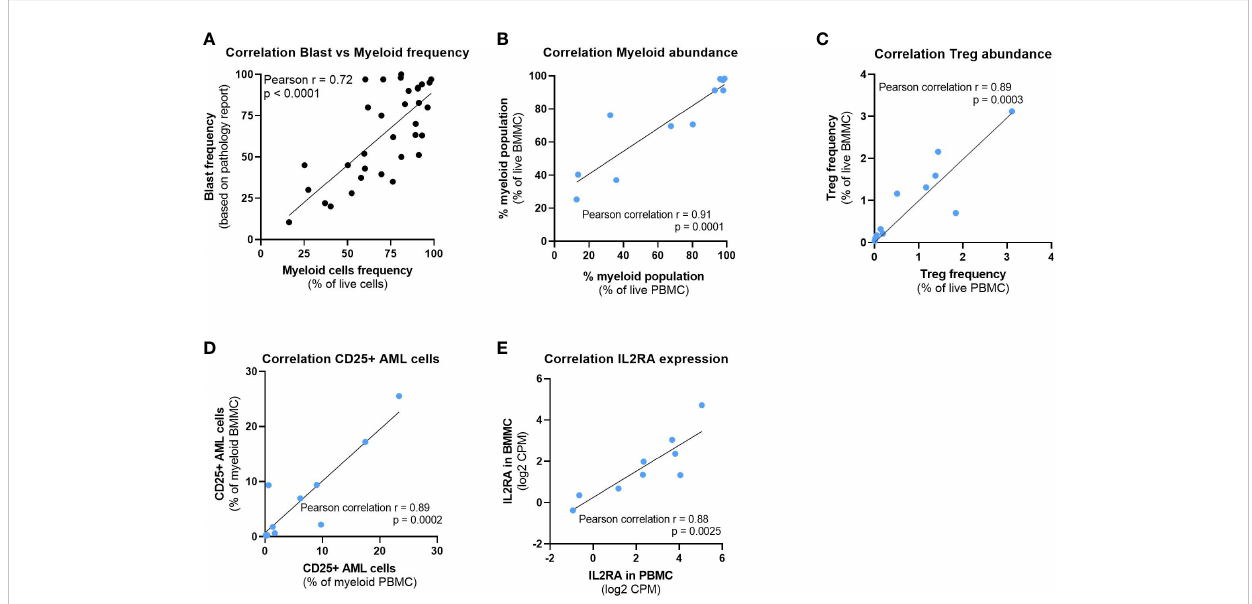
FIGURE 3 Peripheral blood offers a window into the bone marrow composition. (A) Correlation between the myeloid cells frequency detected by high dimensional fl ow cytometry analysis and the blast frequency as per pathology report. (B – D) Correlation between time matched PBMC and BMMC samples from 11 patients of (B) Myeloid cell abundance, (C) Treg abundance and (D) CD25+ AML cells frequency. (E) Correlation of IL2RA gene expression between time matched PBMC and BMMC samples from 9 patients. Pearson correlation r and P values are depicted on the graphs. BMMC: Bone marrow mononuclear cell; PBMC: Peripheral blood mononuclear cell; Treg: Regulatory T cell; CPM: Counts per